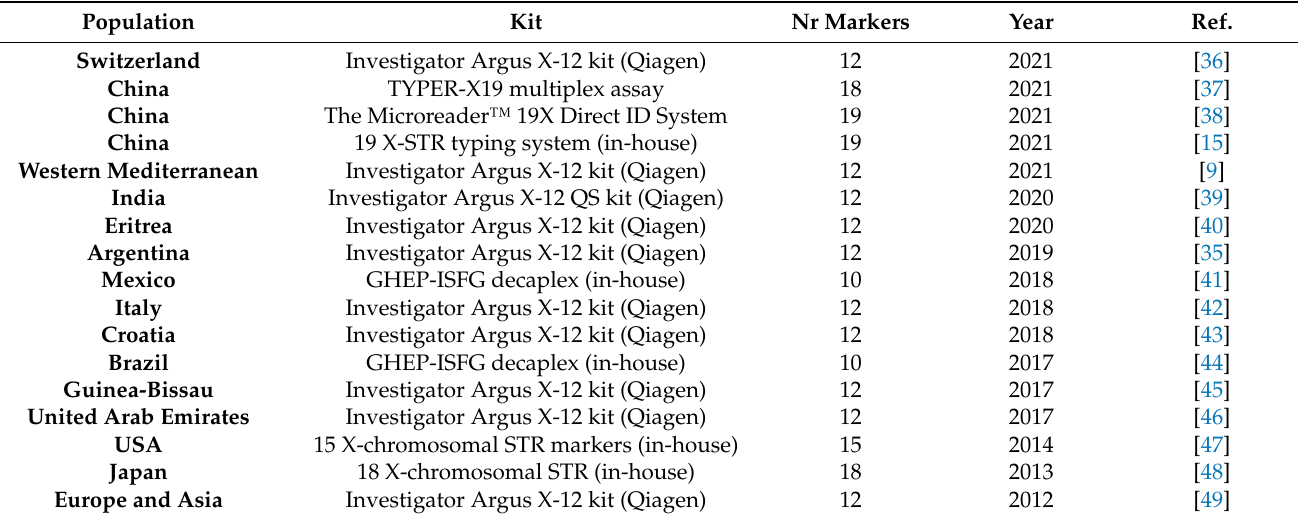
Table 1. Population studies using X-STR markers, published in the last 10